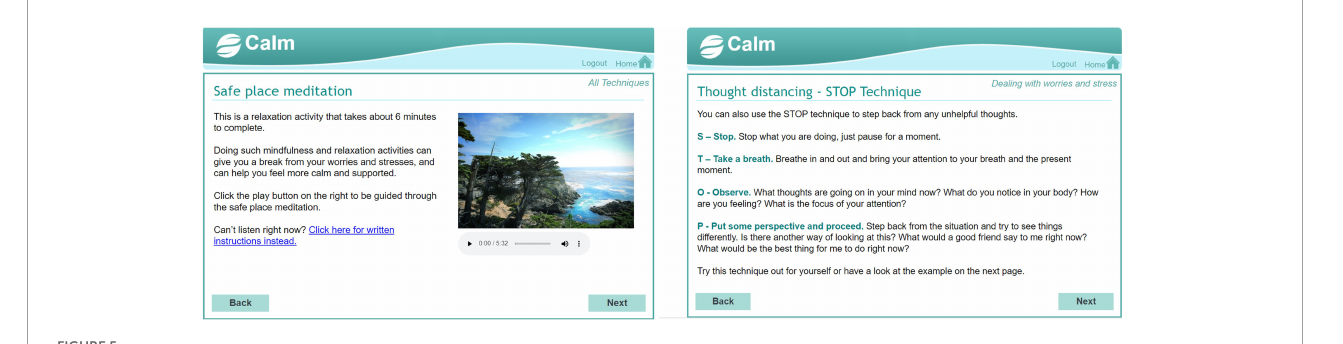
FIGURE5 Example 3 of pages from the CALM